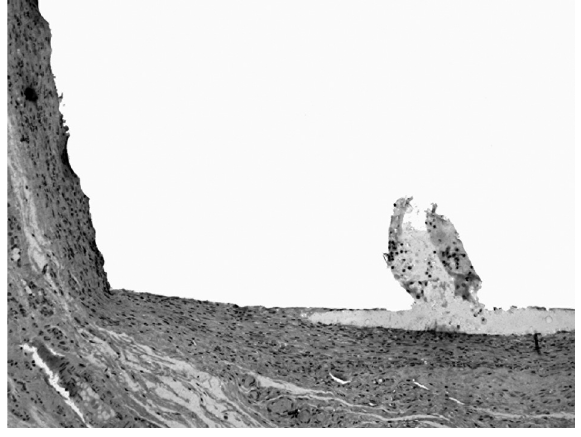
Figure 2. Inflammatory response in diabetic Control group at day 30: specimens showing thin fibrous capsule formation and mild inflammatory cell infiltration consisting of macrophages and lymphocytes (hematoxylin-eosin,